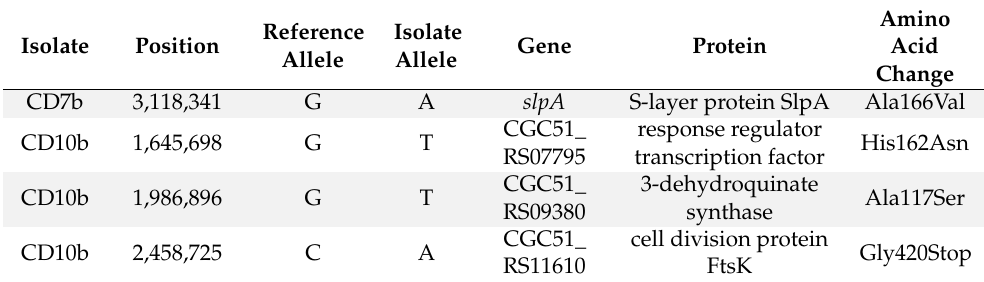
Table 2. Non-synonymous changes found in recurrent isolates with respect to the primary